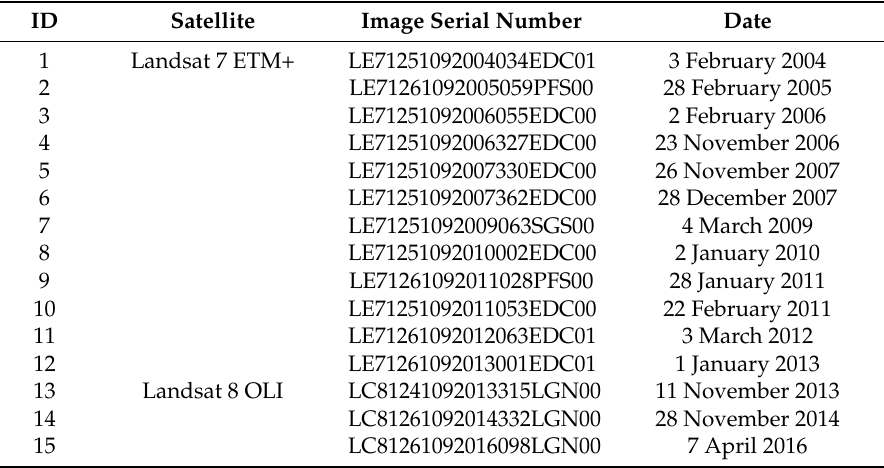
Table 1. Sequential Landsat series images of the PRG.